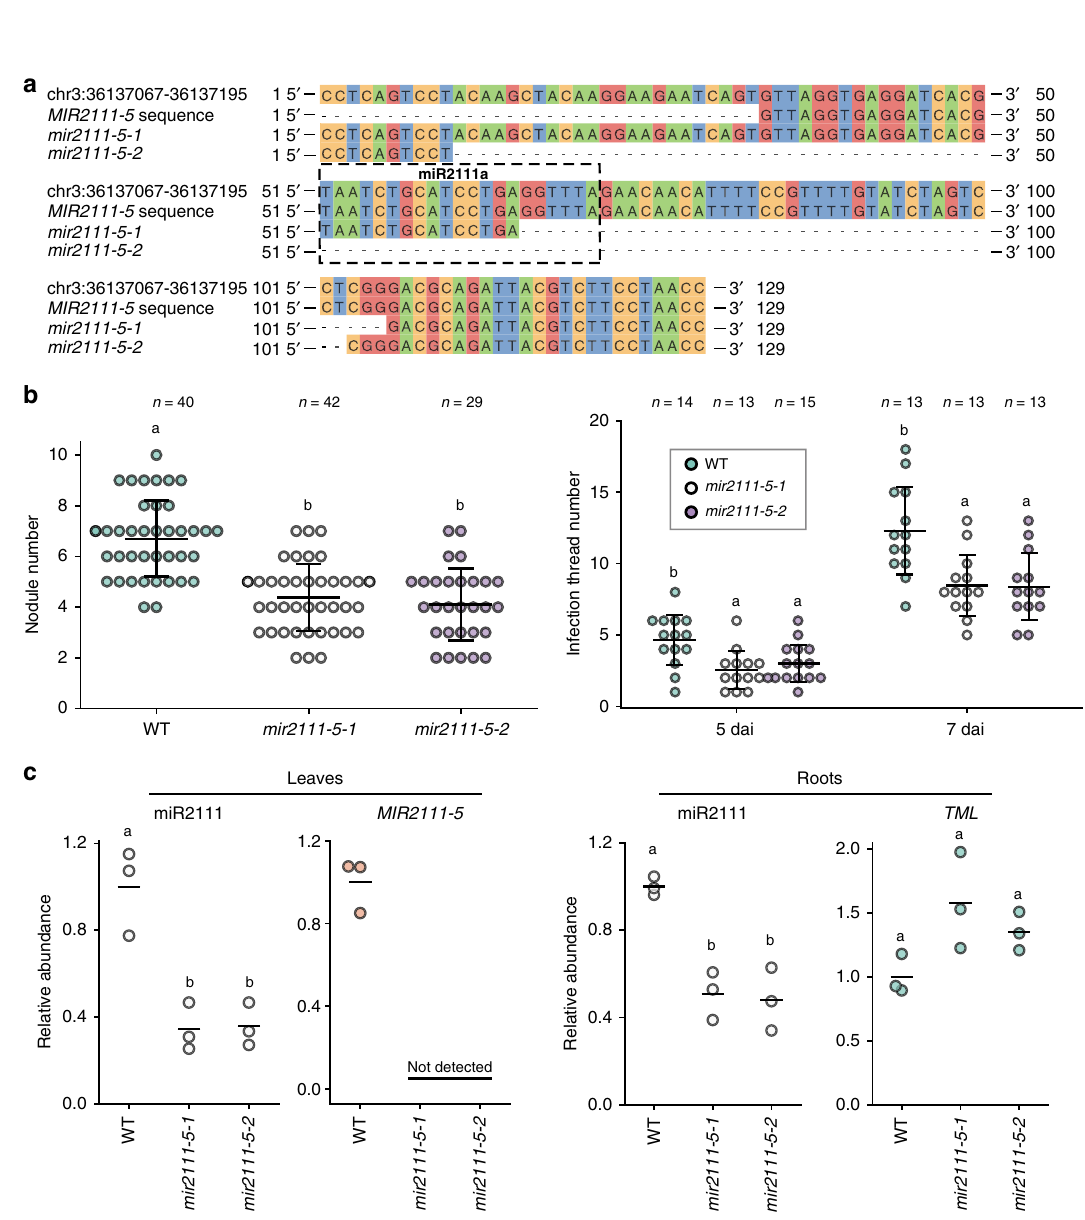
Fig. 4 Reciprocal grafting between wild-type and either MIR2111-5 overexpression or STTM2111 plants. a – e Nodulation at 28 days after inoculation (dai) in wild-type ( a , b ) and MIR2111-5 ox ( c , d ) rootstocks grafted with wild-type ( a , c ) and MIR2111-5 ox ( b , d ) scions. Scale bars: 1 mm. e Nodule numbers on rootstocks of grafted plants (28 dai). f qRT-PCR analyses of mature miR2111s, MIR2111-5 , and TML in rootstocks of the grafted plants (5 dai). OX represents MIR2111-5 ox plants. All values were normalized by the mean value of wild-type self-grafting plants. n = 3 individual biological replicates for each treatment. Bars indicate mean values. Two-sided Student ’ s t test was used to determine statistical difference compared with wild-type self-grafting plants: * P < 0.05; ** P < 0.01; *** P < 0.001; n.s. not signi fi cant. g Nodule numbers in rootstocks of grafted plants between WT and STTM2111 (21 dai). STTM represents STTM2111 plants. e – g Scatterplots show individual biological replicates as dots. Different letters indicate signi fi cant differences ( P < 0.05) from Tukey ’ s honestly signi fi cant difference test. e , g Bars indicate mean ± standard deviation.